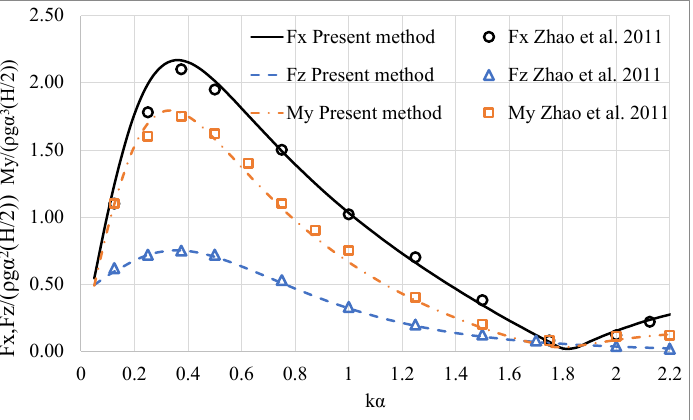
Figure 2. Comparison of the present method results against those from Zhao et al. [32], concerning the exciting forces and moments on a porous cylinder.